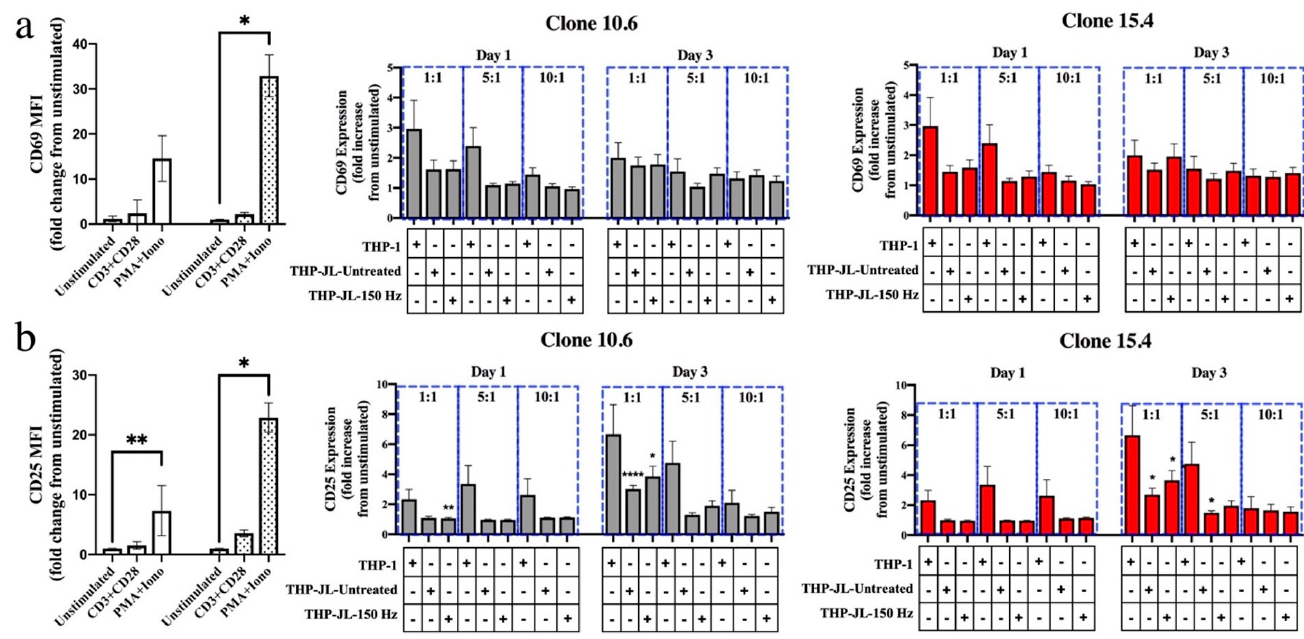
Figure 3. NTP does not stimulate efficient cross-presentation of J-Lat cell-derived antigens on THP-1 macrophages. ( a ) The surface presentation of activation markers CD69 or ( b ) CD25 on CD8+ T lymphocytes in co-culture with M0 macrophages alone (THP-1) or those that had engulfed NTP-naïve (THP-JL-Untreated) or NTP-exposed cells (THP-JL-150 Hz). The fold change in surface display of activation markers for all experimental conditions was calculated relative to the unstimulated CD8+ T-lymphocyte control cultured in the absence of THP-1 macrophages. CD8+ T lymphocytes treated with an anti-CD3 and anti-CD28 antibody cocktail or a PMA and ionomycin cocktail (PMA + Iono) served as positive controls for activation. Cell activation was assessed at days 1 and 3 after introduction of the CD8+ T lymphocytes. Gray and red bars indicate J-Lat clones 10.6 and 15.4, respectively. Data are presented as mean ± SEM from three independent experiments ( n = 3 donors), with three replicates per condition. Statistical significance was calculated relative to the unstimulated CD8+ T-lymphocyte control, as well as the CD8+ T lymphocyte and THP-1 macrophage negative control using the Brown–Forsythe and Welch’s Anova tests with Dunnett’s post hoc test. (* p ≤ 0.05, ** p < 0.01, **** p < 0.0001).